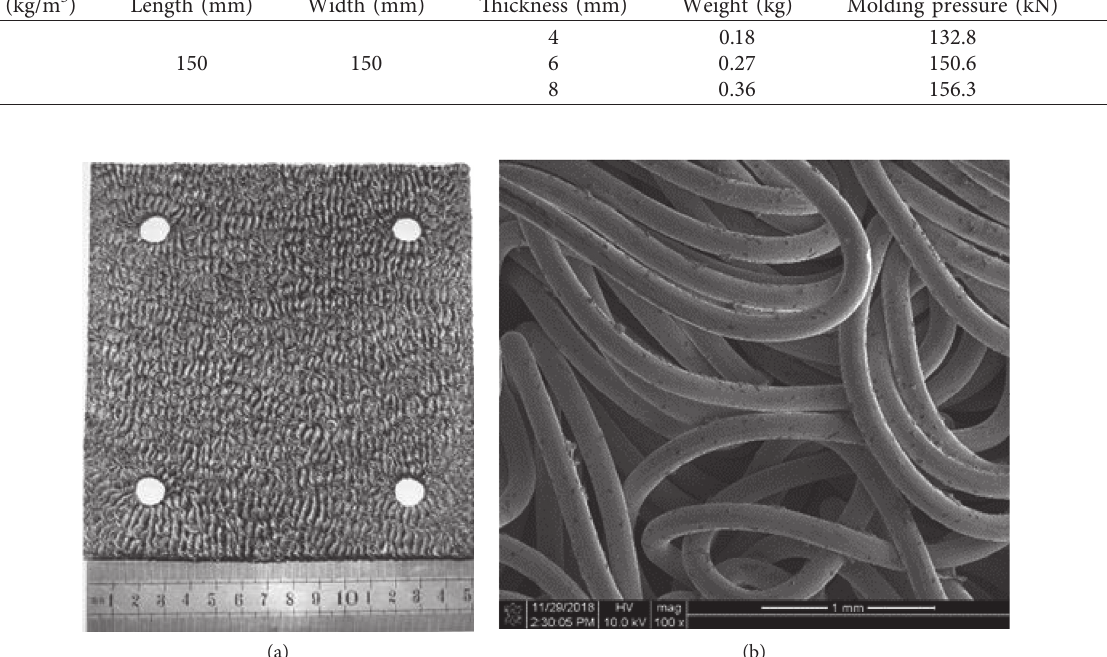
Figure 3: EMWM specimen. (a) EMWM layer. (b) SEM image of the EMWM (100 ×